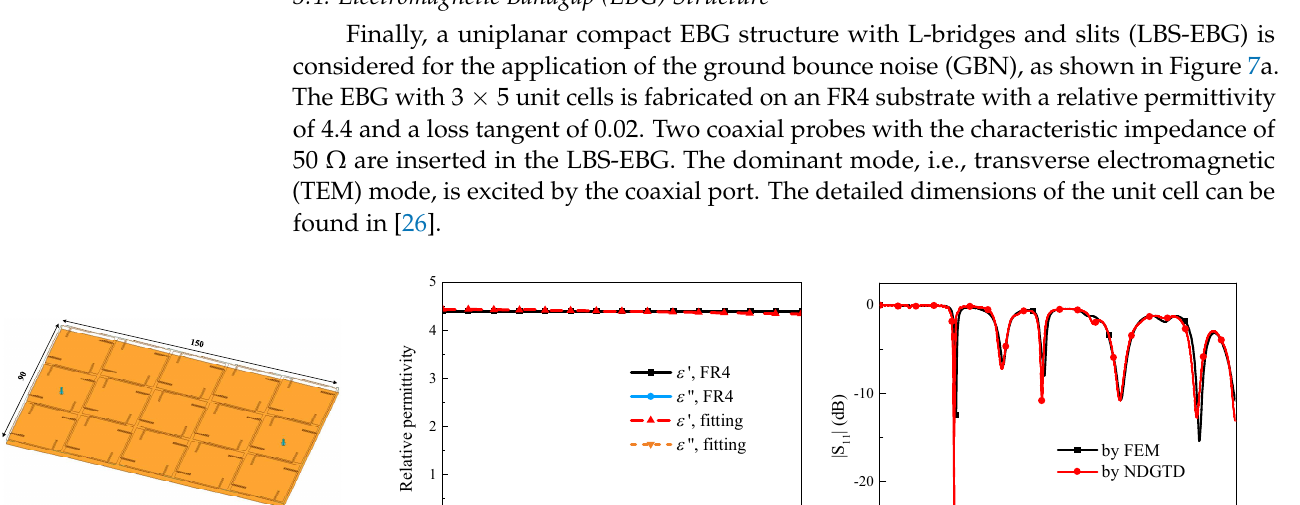
Figure 6. Dual-mode circular horn antenna: ( a ) topology, ( b ) S-parameters, and ( c ) directivity at 10GHz. The contour of the horn is a polygon formed by connecting the following points in turn: o (0, 0, 0), p 1 (35.5 mm, 0, 0), p 2 (35.5 mm, 0, 90 mm), p 3 (38 mm, 0, 226 mm), p 4 (78 mm, 0, 366 mm), p 5 (101 mm, 0, 423 mm), and p 6 (0, 0, 423 mm).